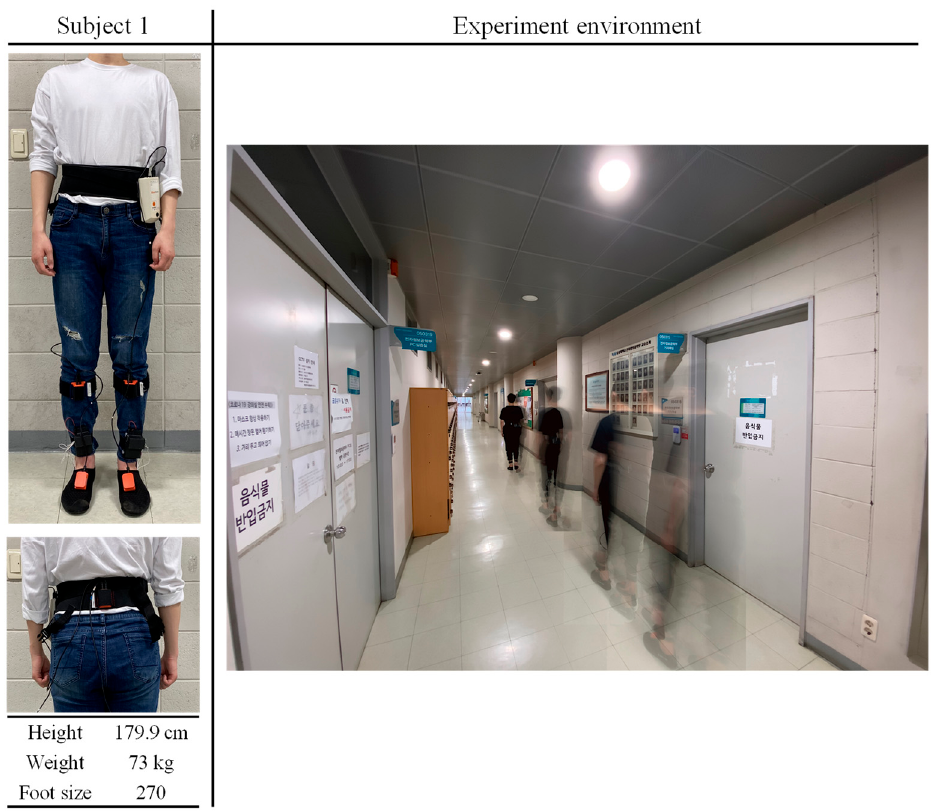
Figure 15. Environment and additional subject for acquisition of the validation dataset.